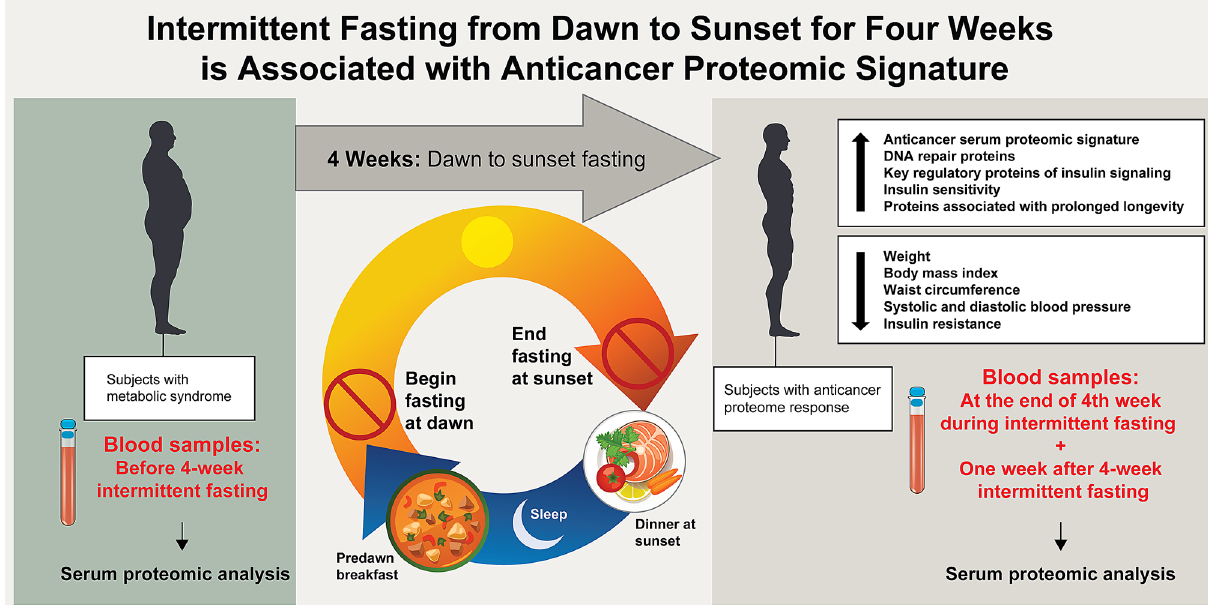
Figure 1. Intermittent fasting from dawn to sunset (dusk) for four weeks. Subjects fasted (no eating or drinking) for more than 14 h. daily for 29 days, from May 06, 2019, until June 03, 2019. The minimum required duration of daily fasting from dawn to sunset was 14 h., 8 min for the shortest day (May 6, 2019), and 14 h., 42 min for the longest day (June 03, 2019). Ramadan fasting is a unique form of intermittent fasting from dawn to sunset (dusk) without eating or drinking during the month of Ramadan based on the lunar calendar 16 and has several major unique features: (1) Fasting is exclusively practiced during the human activity hours from dawn to sunset and is for both eating and drinking, which differentiates the dawn to sunset intermittent fasting from the other forms of intermittent fasting where eating light meals and/or drinking are allowed during the fasting window; (2) Although the main meals are at transition time zones of the day (pre-dawn breakfast and dinner at sunset), eating and drinking outside these transition time zones is allowed as long as it is within the non-fasting window; (3) There is no interventional calorie or energy restriction; (4) Daily fasting window is in synchrony with circadian rhythm and earth’s rotation on its axis because the daily fast starts at dawn (the first transition time zone of the day) after a pre-dawn breakfast and ends at sunset (dusk) (the second transition time zone of the day) with dinner; (5) Monthly fasting window is in synchrony with the moon’s rotation around the earth and lunar phases because the monthly fasting starts and ends when the new moon is sighted (with permission from Baylor College of